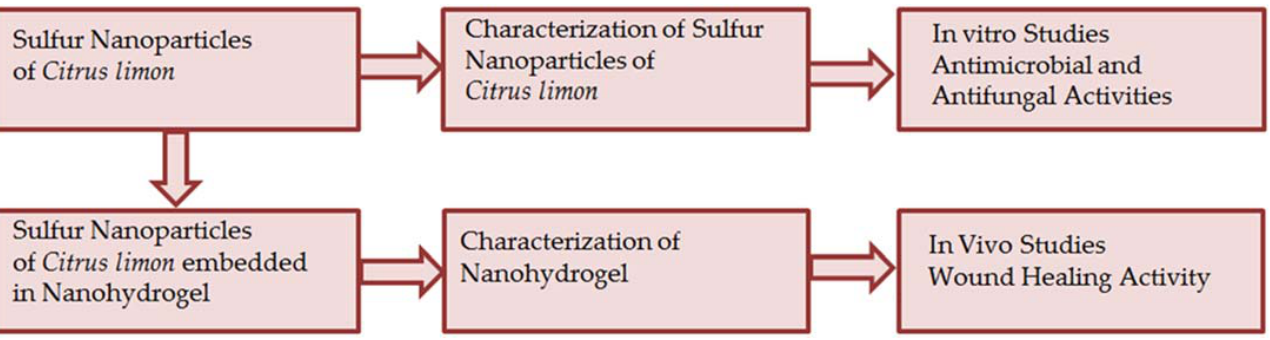
Figure 11. Scheme of the experimental procedure.